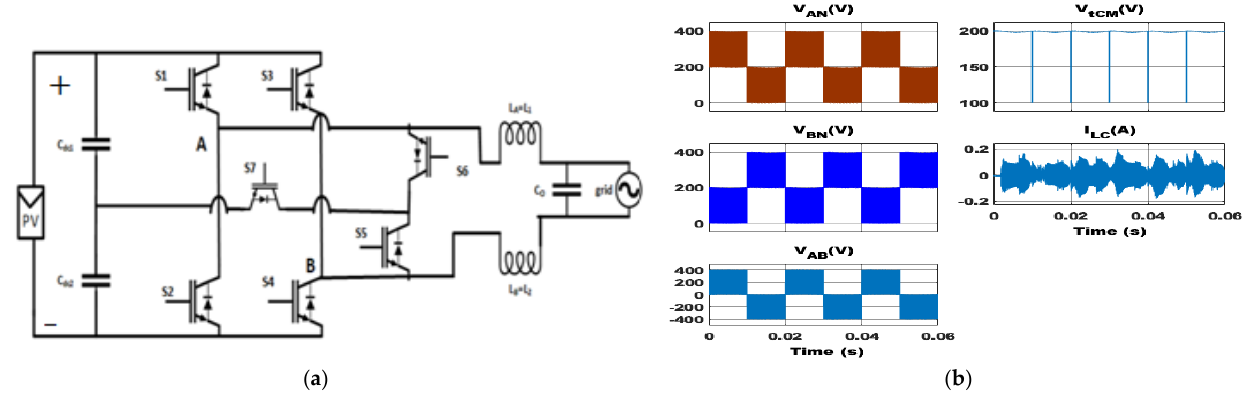
Figure 17. HERIC Active-II topology: ( a ) circuit structure; ( b ) simulation results. Figure 18. HBZVR-D topology: ( a ) circuit structure; ( b ) simulation